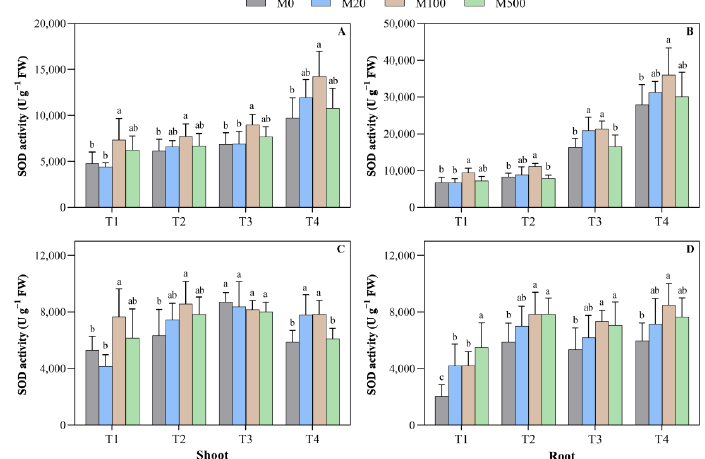
Figure 4. Effects of exogenous melatonin on the superoxide dismutase (SOD) activity of rice seed germination under high temperature stress. Means ± SEs with different letters in each parameter indicate significant statistical differences ( p < 0.05). ( A ) Superoxide dismutase (SOD) activity of shoot (7 d); ( B ) superoxide dismutase (SOD) activity of root (7 d); ( C ) superoxide dismutase (SOD) activity of shoot (9 d); and ( D ) superoxide dismutase (SOD) activity of root (9 d).